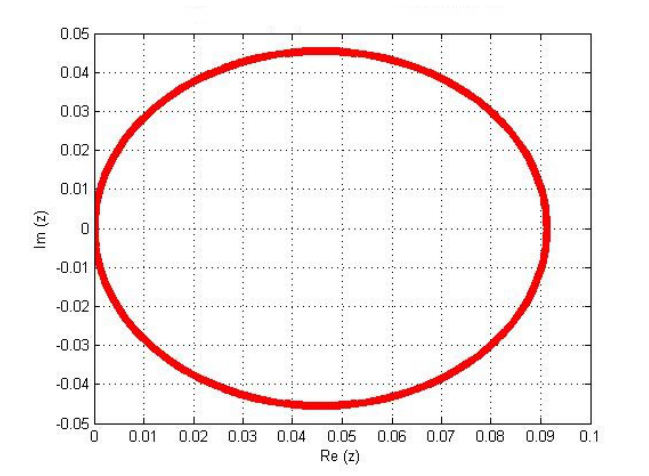
Figure 1. RAS of